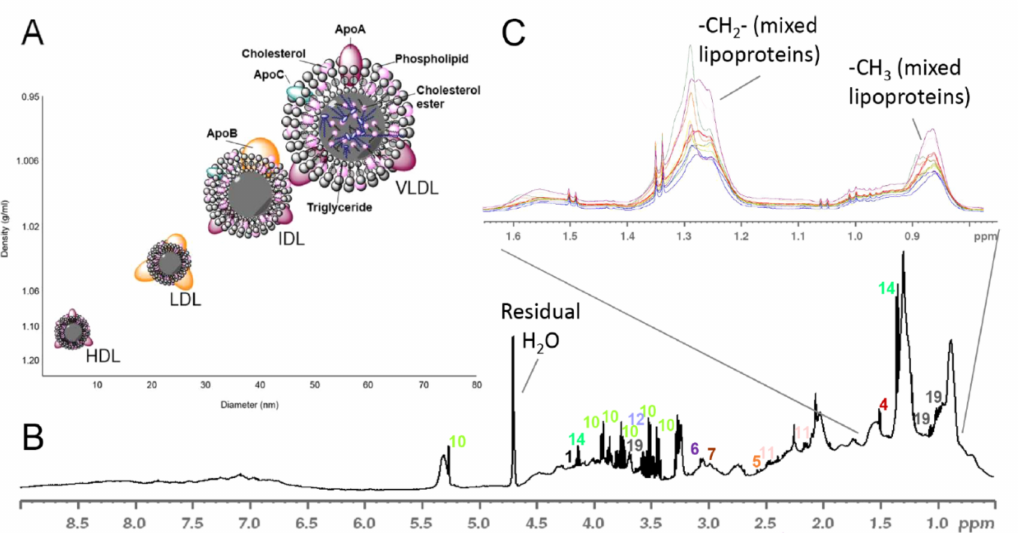
Figure 5. ( A ) Density and size of lipoprotein composition ( B ) 1H NMR spectrum of a serum sample. ( C ) Different lipoprotein signals from several samples with differing compositions. Reprinted by permission from [44]. Copyright 2018 ACS